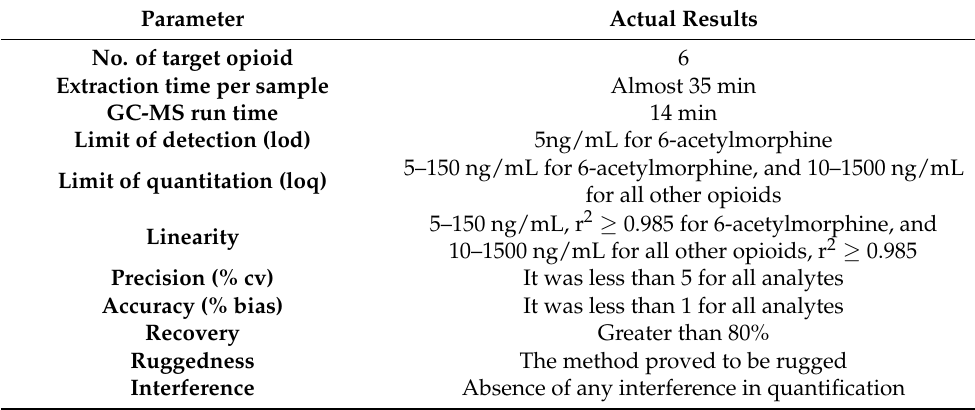
Table 6. Summarized results of method validation